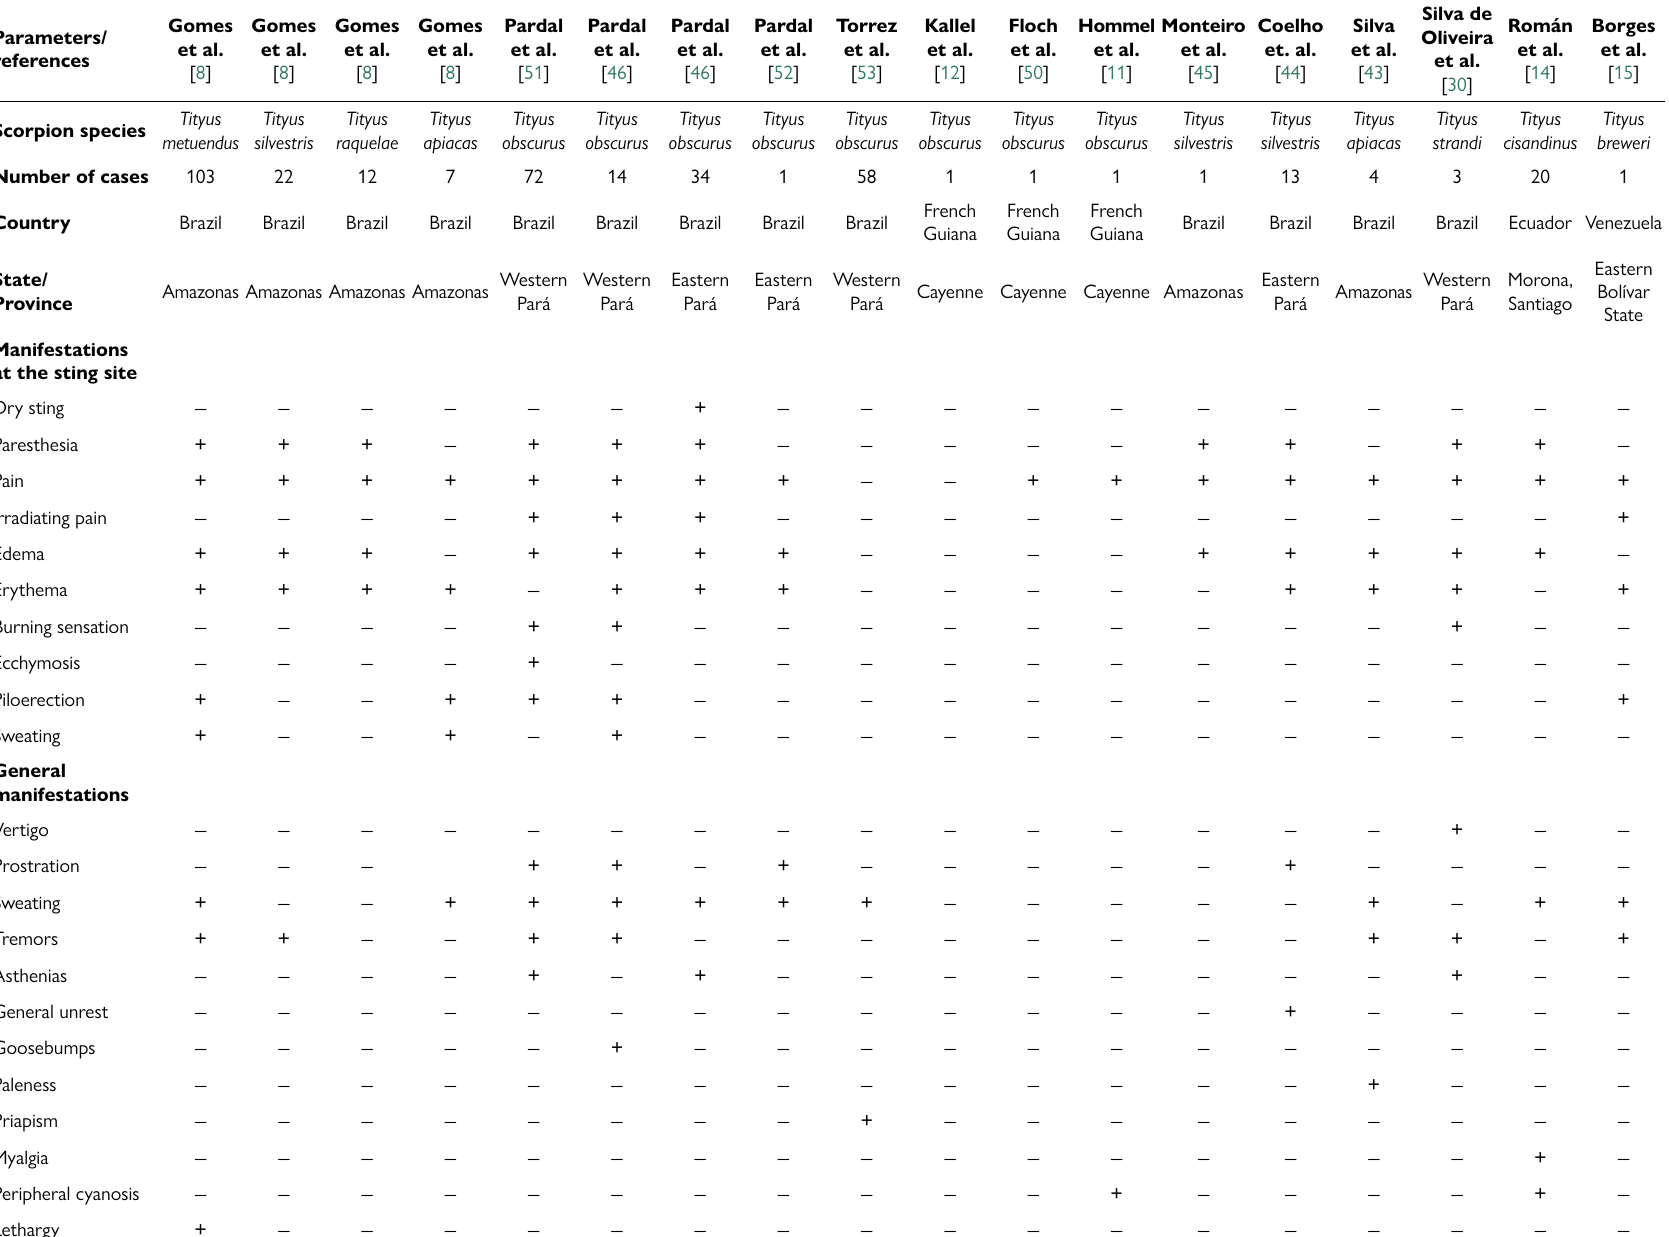
Table 2. Scorpion envenomation cases recorded in the Amazon region with positively identified associated species in the genus Tityus in the period from 1950 to